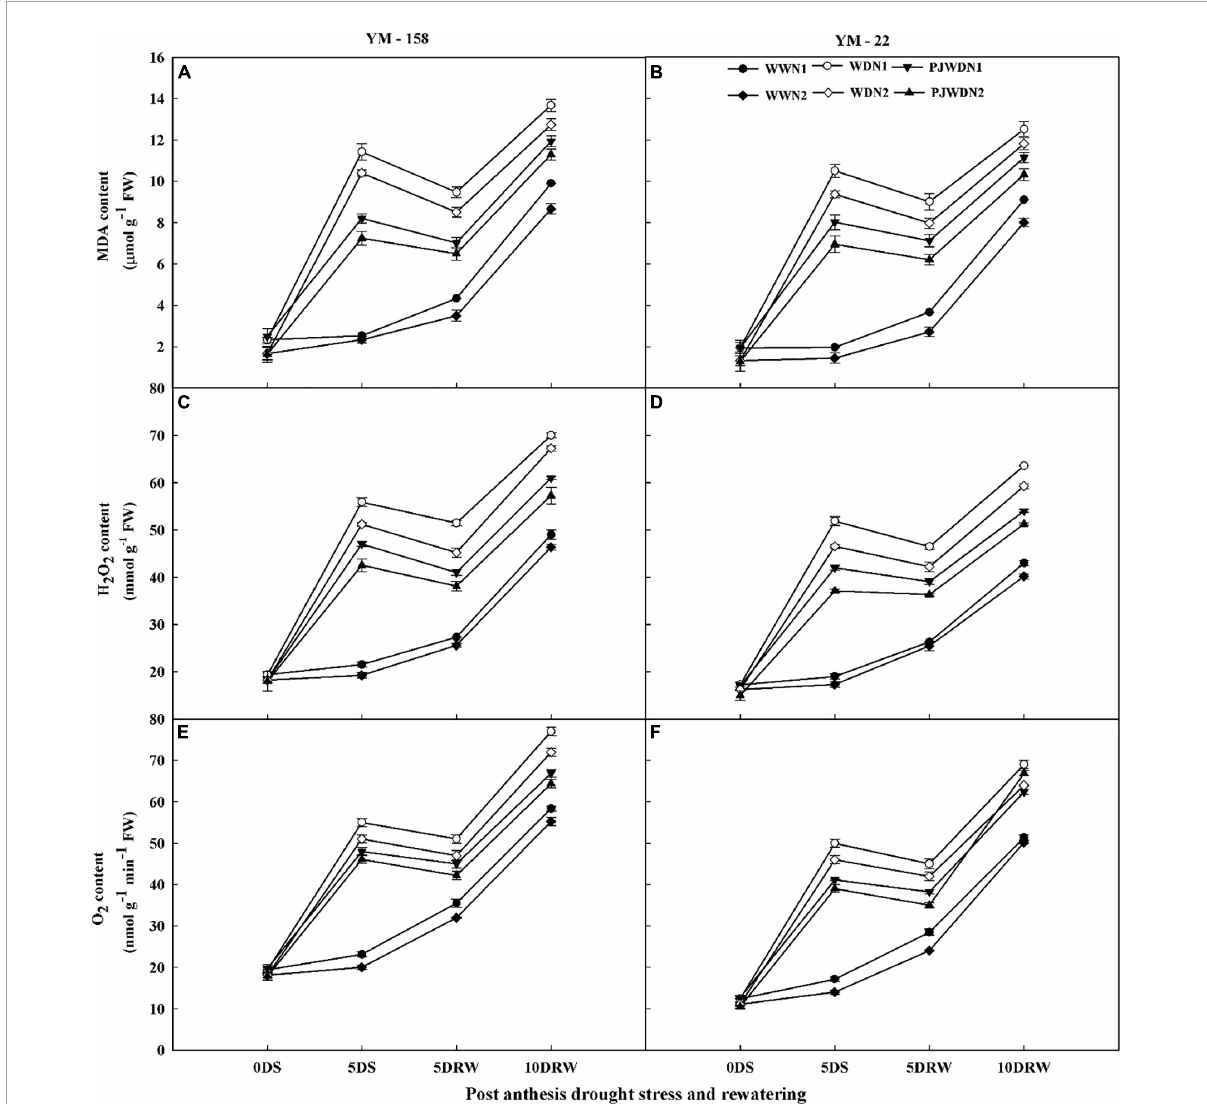
FIGURE6 Effects of pre-drought priming on malondialdehyde (MDA), hydrogen peroxide (H 2 O 2 ), and superoxide anion radical (O 2 − ) content in response to post-anthesis drought stress under two nitrogen (N) rates (N1, 180 and N2, 300) in Yangmai-158 (A,C,E) and Yangmai-22 (B,D,F) wheat cultivars. Treatments: WW (control), no priming at jointing + no post-anthesis drought stress; PJWD, priming at jointing + post-anthesis drought stress; and WD, no priming at jointing + post-anthesis drought stress. Pre-drought priming was completed during the jointing stage, and post-anthesis drought stress was applied from 7 to 14 days after anthesis. The horizontal axis shows the time course of the sampling: 1 day before drought stress (0DS), 5 days after drought stress (5DS), and 5 and 10 days after re-watering (5DRW and 10DRW). Each vertical bar above the mean value indicates the standard error of three replicates ( n = 3) by using three-way ANOVA at P <